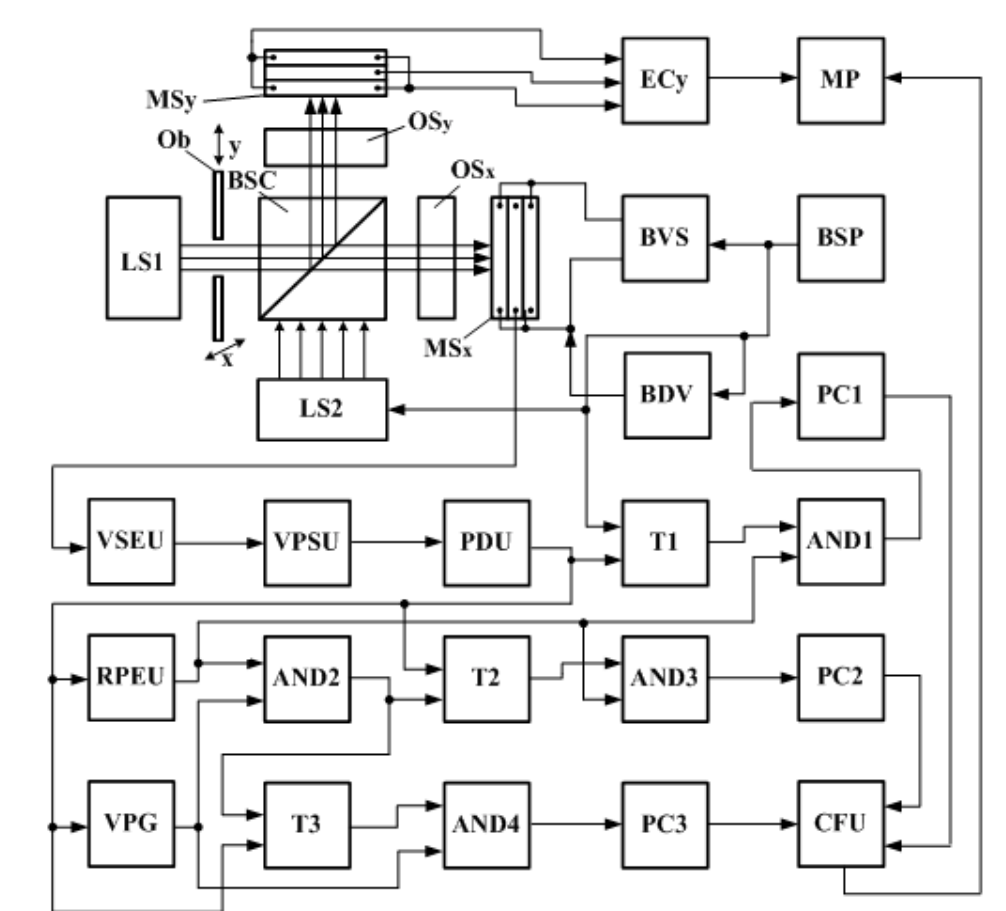
Figure 5. Functional diagram of a device for measuring the coordinates of objects.